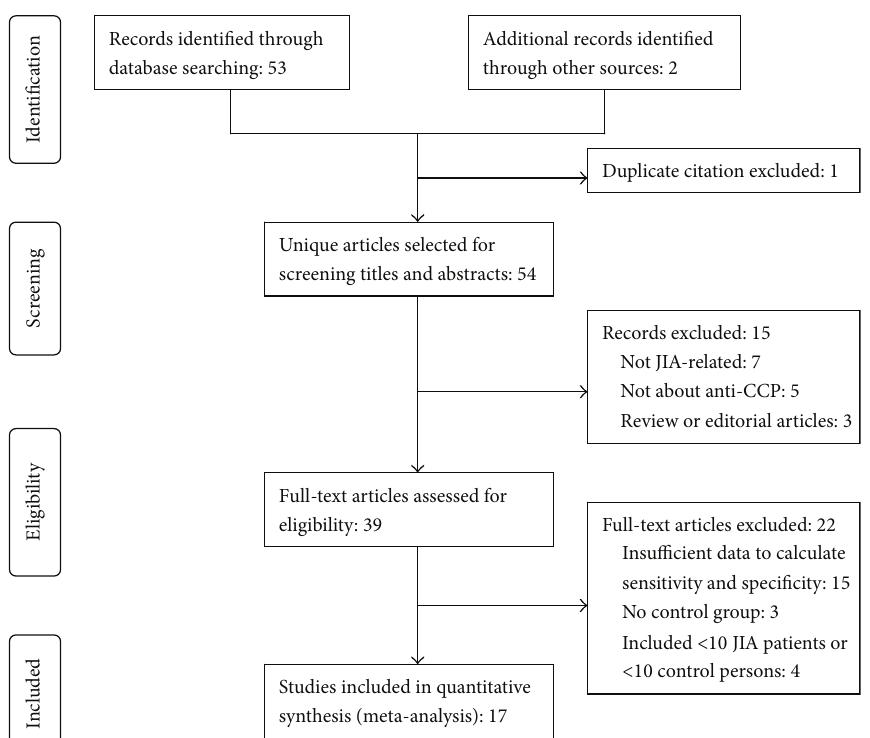
Figure 1: Articles selection process and reasons for exclusion of